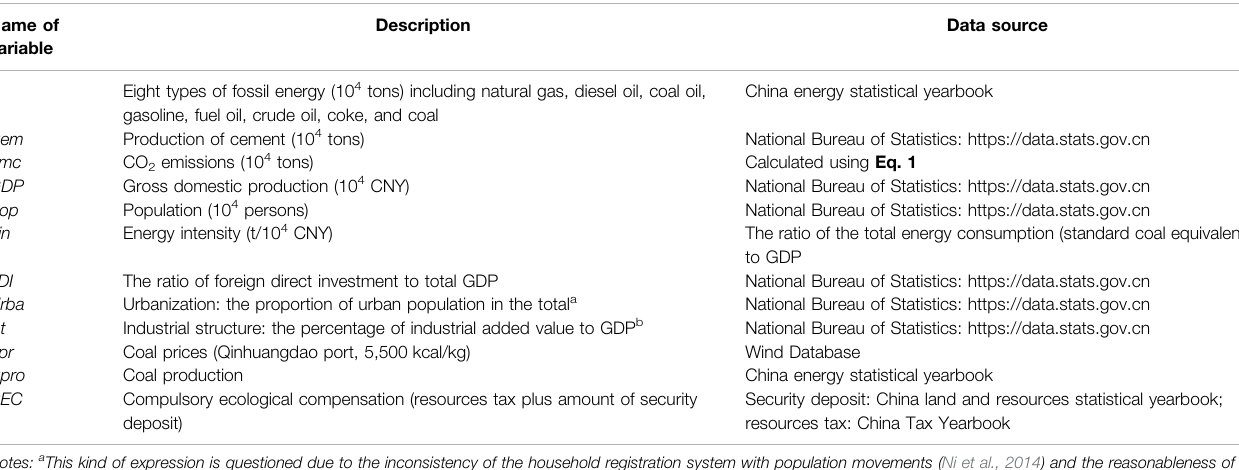
TABLE 1 | List of explanatory variables used in the analysis and data sources.